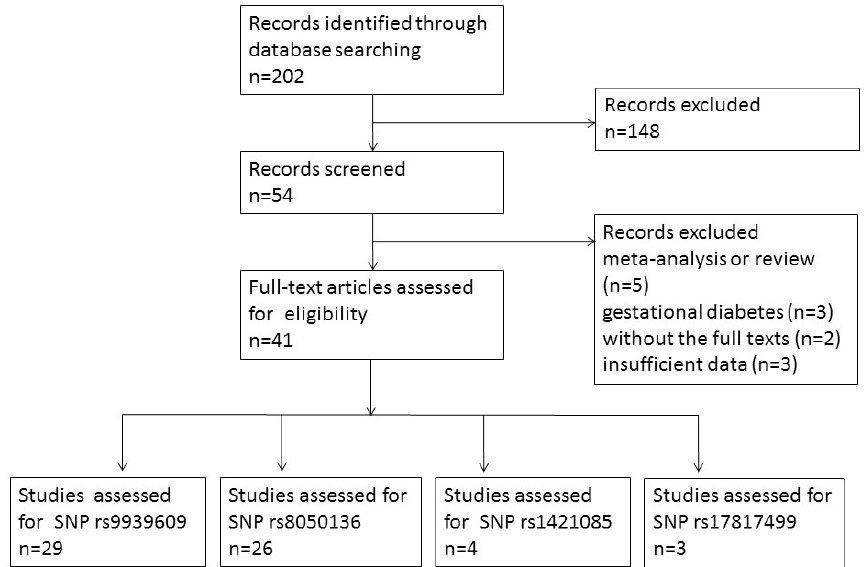
Figure 1. Study selection flow chart based on preferred reporting items for spatial analysis and meta-analysis. Table 1. Characteristics of the included studies.